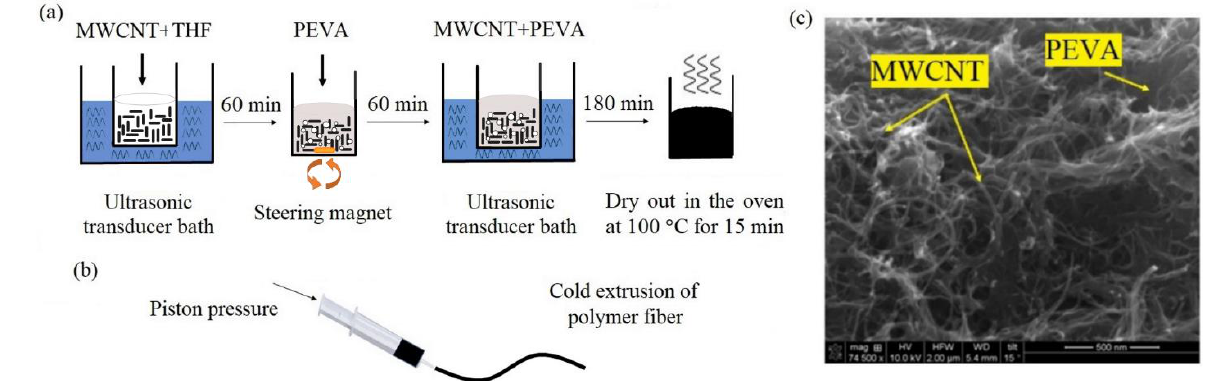
Figure 8. ( a ) Fabrication process of the MWCNT-PEVA conductive polymer ( b ) the extrusion pro-